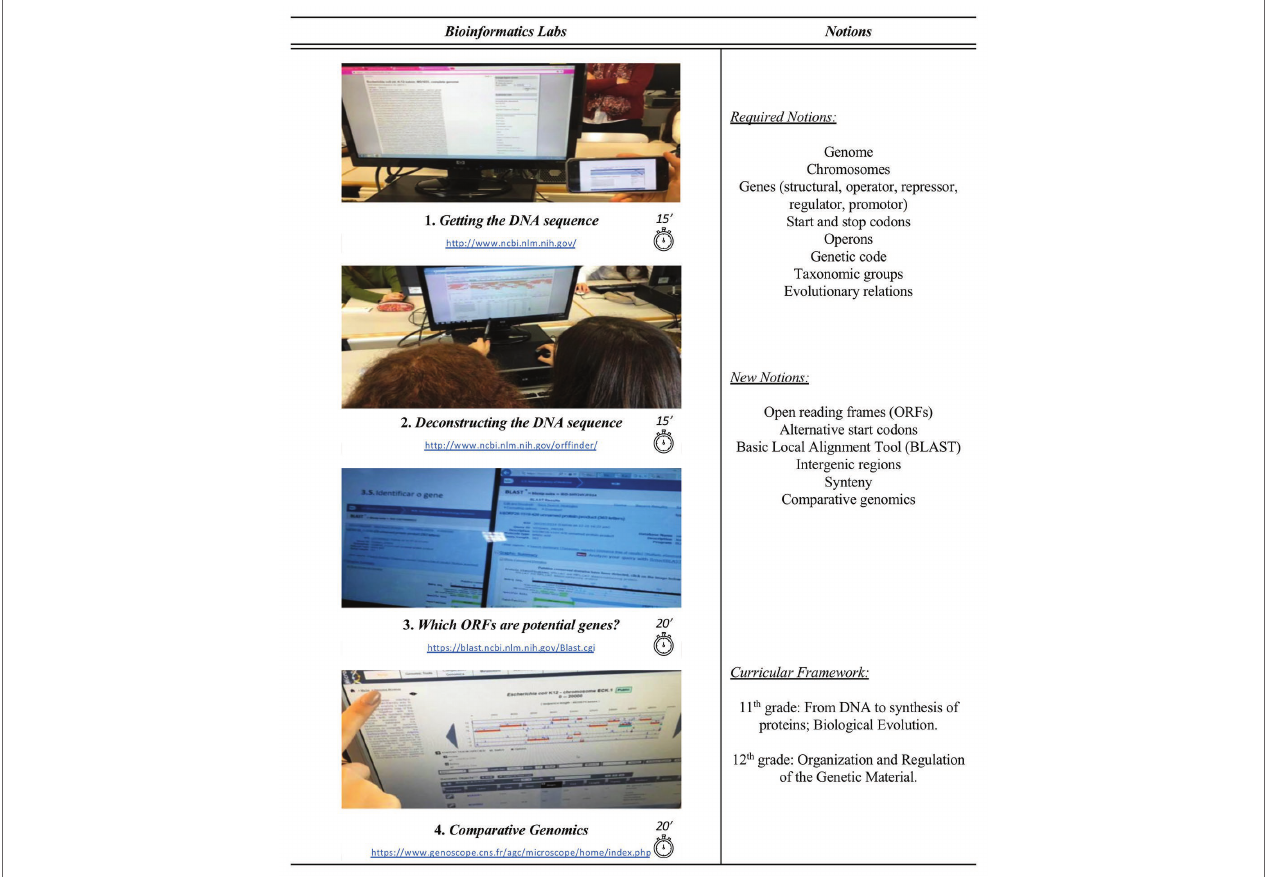
FIGURE 1 | Bioinformatics laboratories framed within the curricular biology contents for high school to reinforce genomics topics currently required and to introduce new core